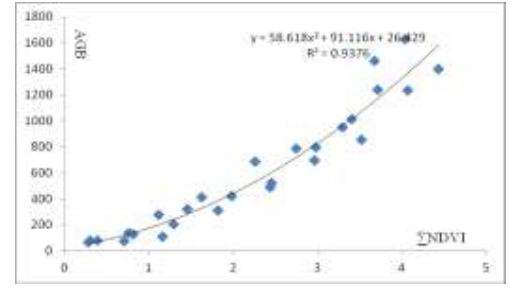
Figure 2. the sketch of relationship between AGB &